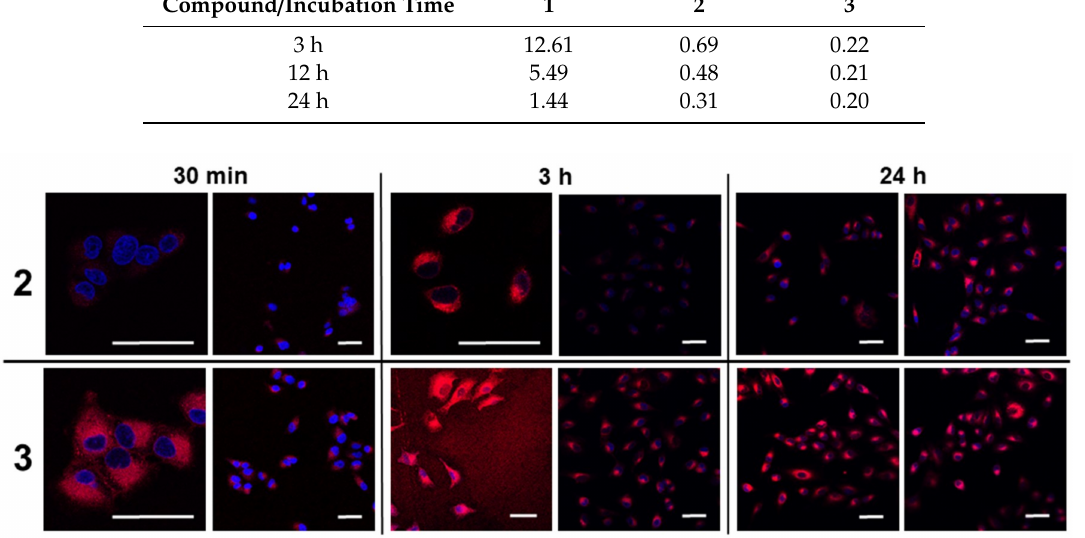
Figure 5. Time-dependent intracellular uptake of 2 and 3 by A549 cells without irradiation after 30 min, 3 h, and 24 h incubation assessed using CLSM. The concentration of PS was 2 µ M in each sample. Merged images are shown with DAPI (cell nuclei, blue) and PS (chlorins, red) in 2 or 3 . Bars, 50 µ